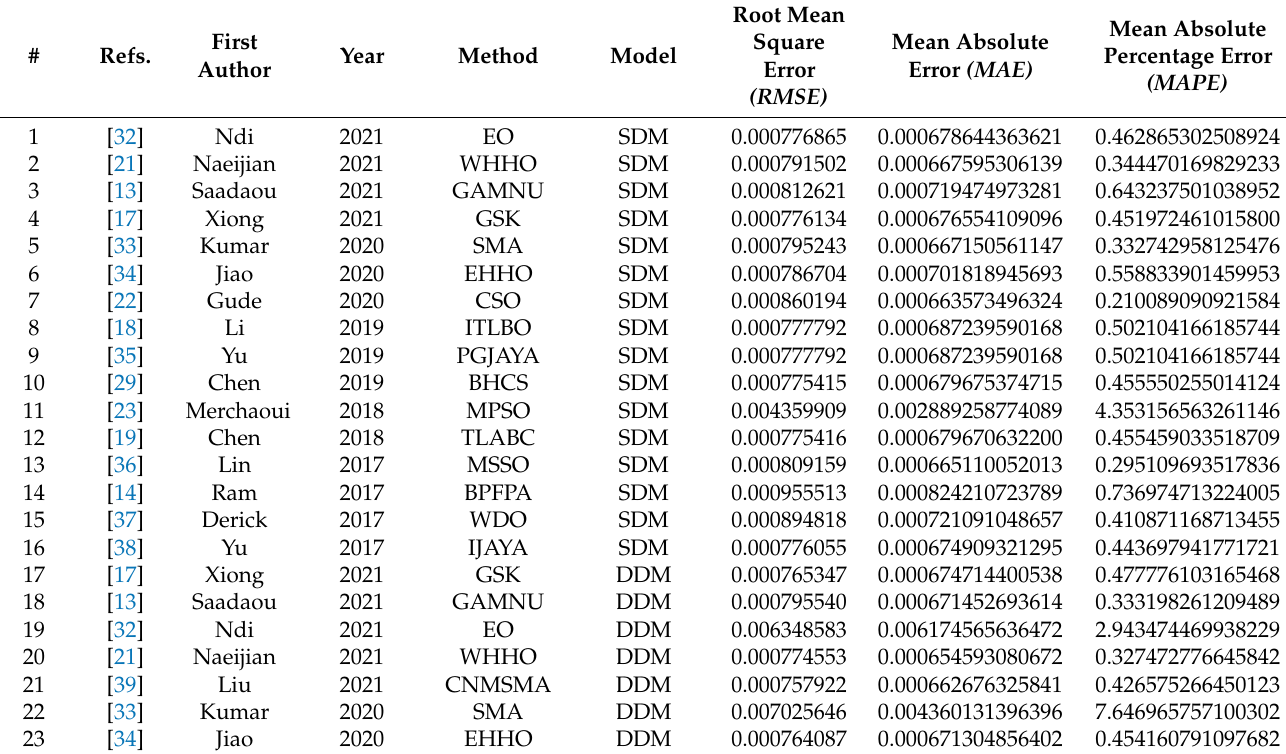
Table 1. Numerical results obtained for the solar RTC France